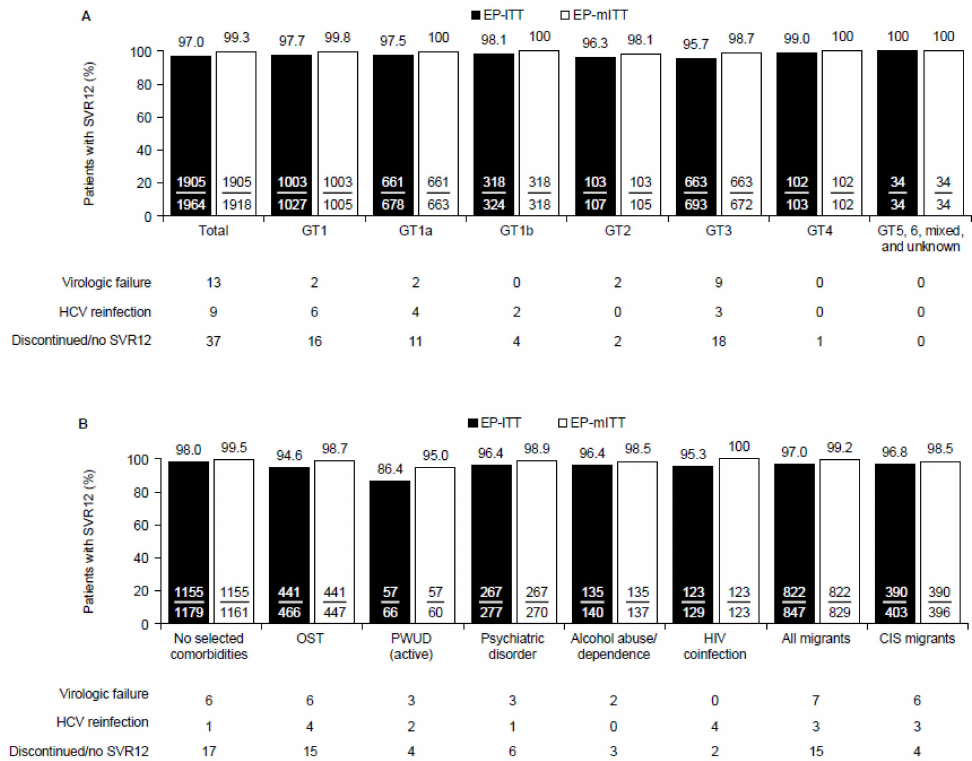
Figure 1. SVR12 rates in the effectiveness population according to ( A ) HCV genotype and ( B ) key comorbidities and migrant status (primary effectiveness endpoint). Patients who discontinued GLE/PIB prematurely and achieved SVR12 were counted as virologic responders ( n = 11). EP-mITT analysis excluded patients who discontinued GLE/PIB prematurely and did not achieve SVR12, and patients with HCV reinfection. n = 258 patients in the EP-ITT population were cirrhotic; 252 (97.7%) of these patients achieved SVR12. CIS, Commonwealth of Independent States (Armenia, Azerbaijan, Belarus, Kazakhstan, Kyrgyzstan, Moldova, Russia, Tajikistan, and Uzbekistan); EP, effectiveness population; GT, genotype; HCV, hepatitis C virus; HIV, human immunodeficiency virus; ITT, intention to treat; mITT, modified intention to treat; OST, opioid substitution therapy; PWUD (active), people who actively use drugs; SVR12, sustained virologic response at PTW12. In TN patients, the overall EP-ITT SVR12 rate was 97.1% ( n / N = 1727/1778) and remained high regardless of cirrhosis status (TN/NC: n / N = 1475/1520, 97.0%; TN/CC: n / N = 252/258, 97.7%) or the duration of therapy (12 weeks, or 8 weeks after the